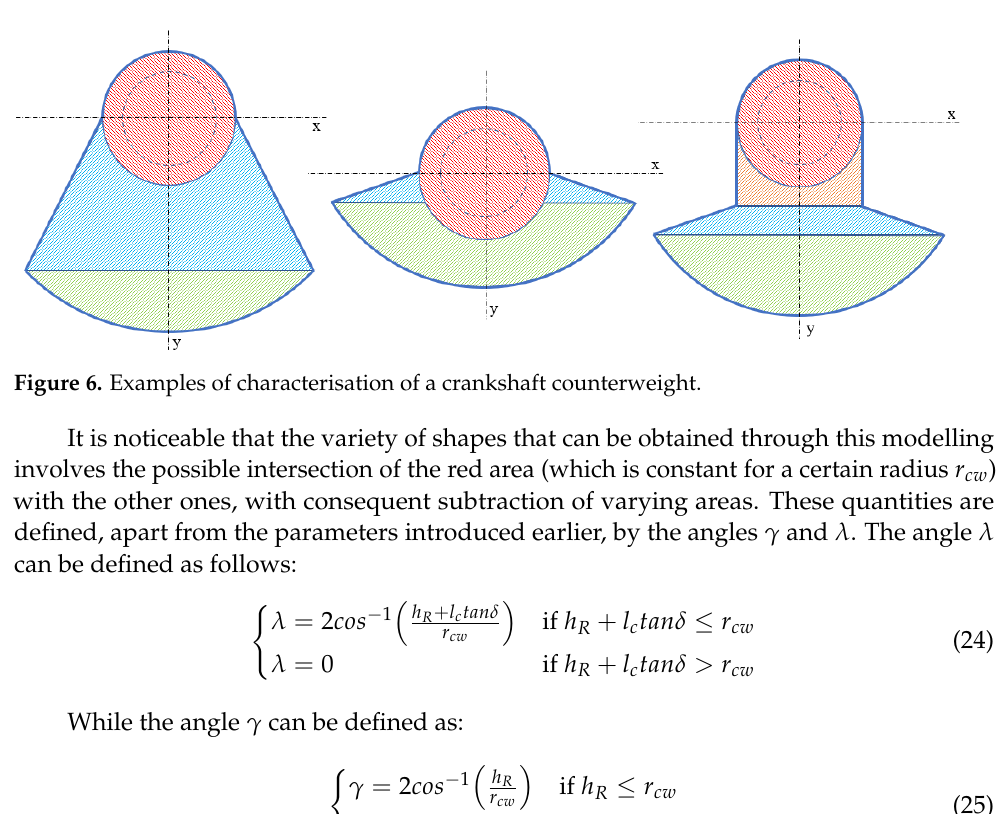
Figure 5. Model and quotas of the crankshaft counterweight.